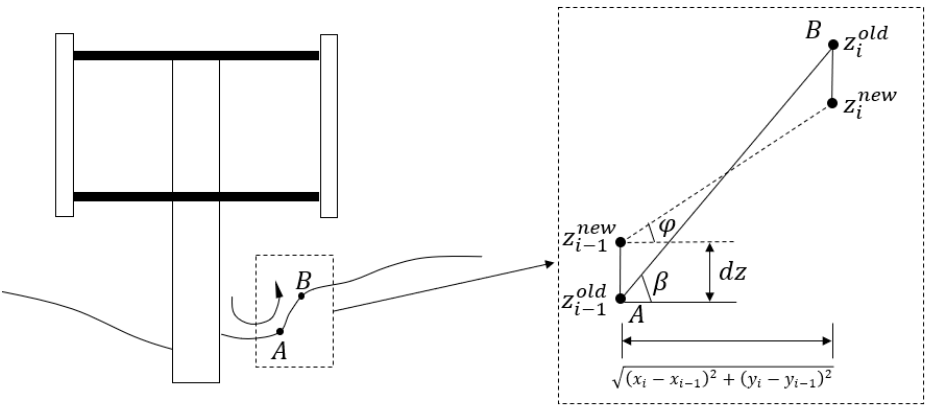
Figure 6. Illustration sketch of sand slide model.